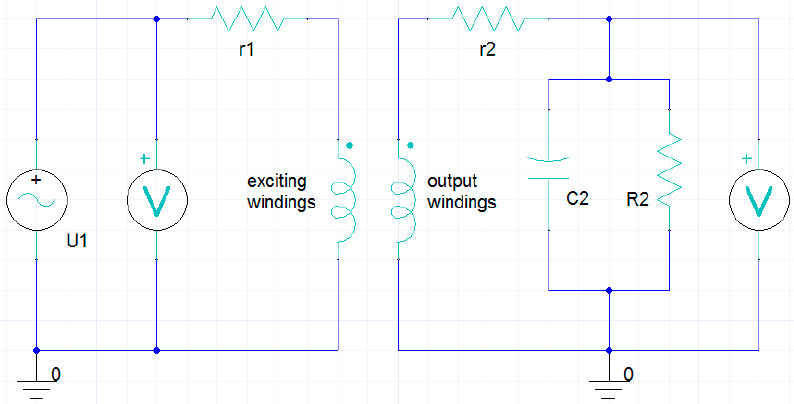
Figure 6. The electric circuit.